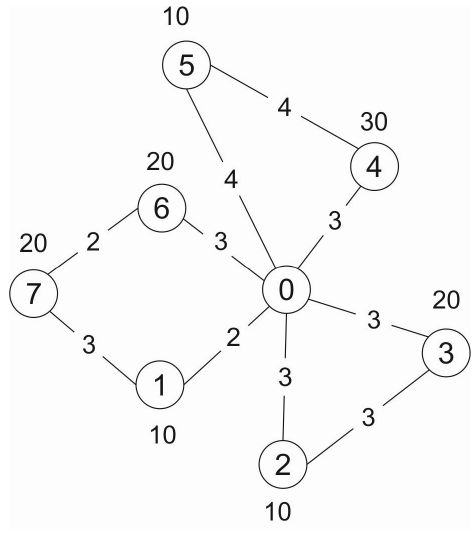
Figure 1. A feasible CVRP